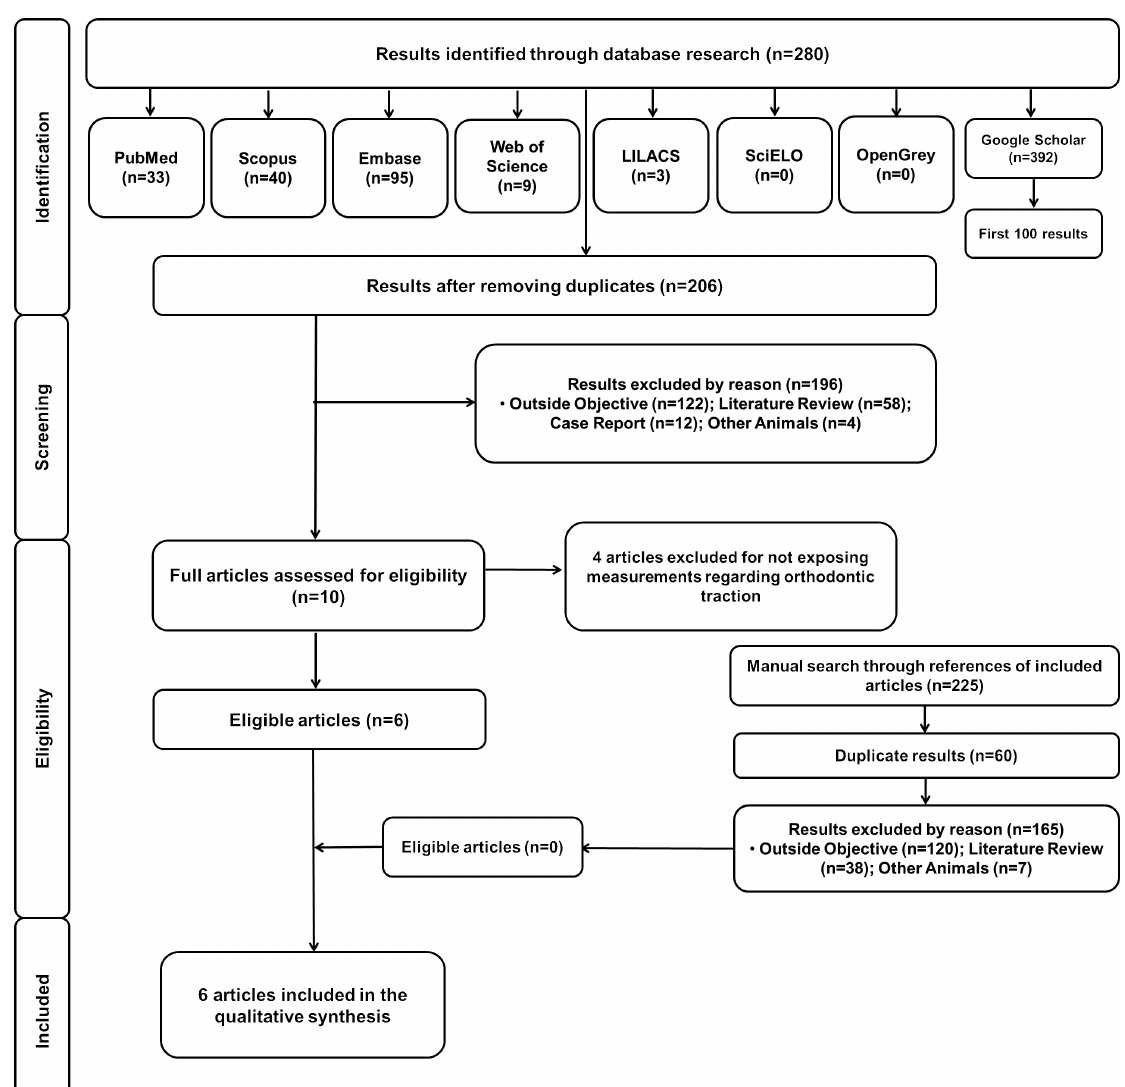
Figure 1 - Flow diagram of the strategies used for identification, screening, and inclusion of studies in the systematic review - adapted from